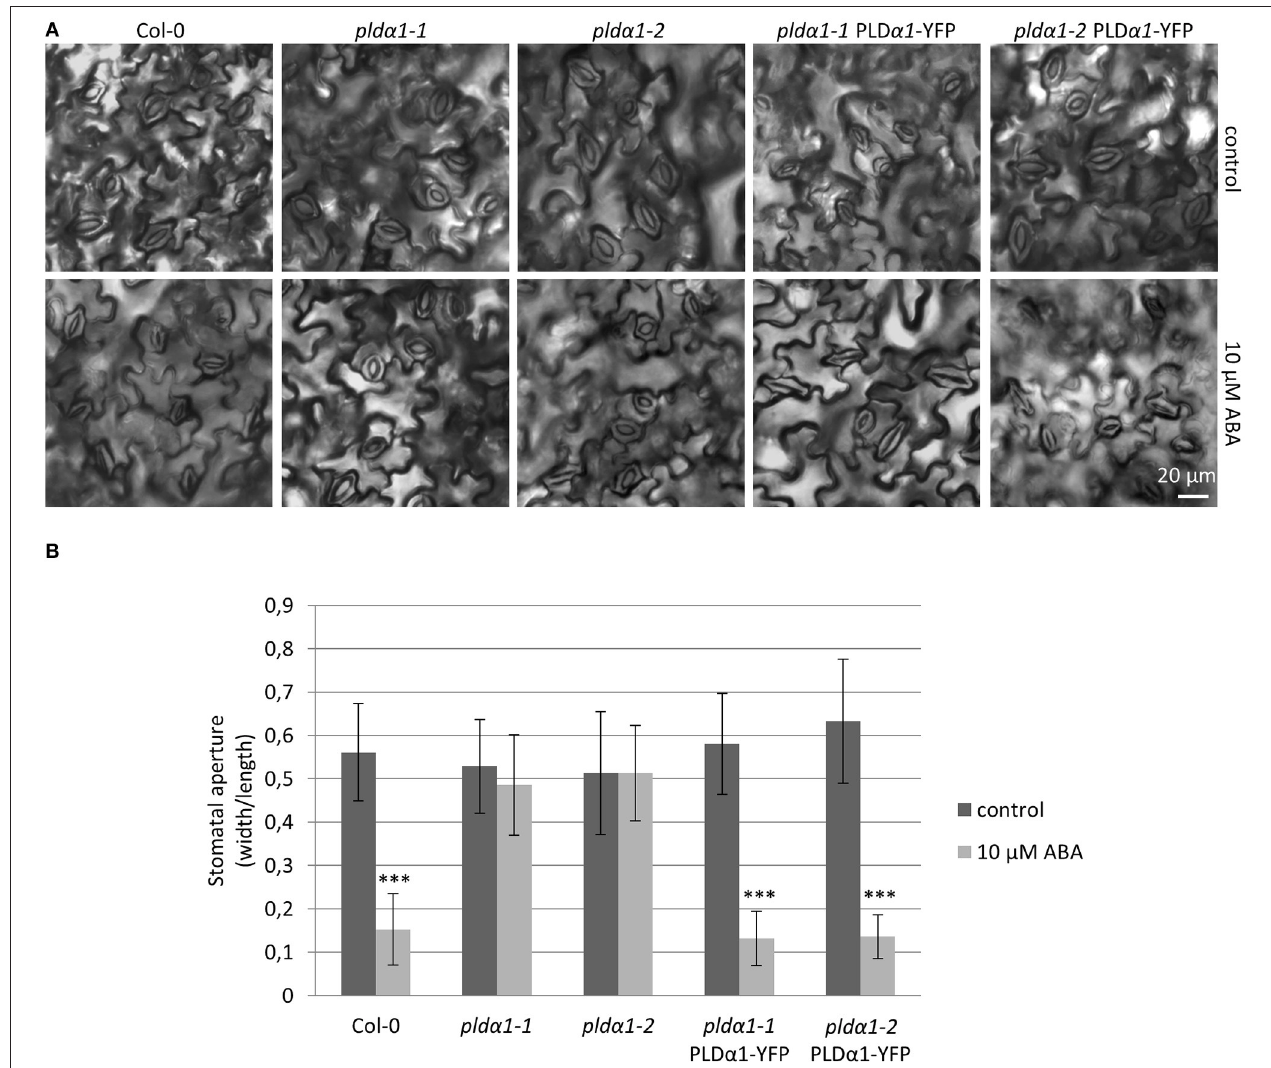
FIGURE 2 | ABA-induced stomatal closure in pld α 1 mutants and rescued plants. (A) Cotyledon epidermis of 7 days old Col-0, pld α 1-1, pld α 1-2, pld α 1-1 PLD α 1-YFP, and pld α 1-2 PLD α 1-YFP plants showing opening of stomata in control condition and after 2h treatment with 10 µ M ABA. (B) Aperture of cotyledon stomata guard cells of Col-0, pld α 1-1, pld α 1-2, pld α 1-1 PLD α 1-YFP, and pld α 1-2 PLD α 1-YFP (measured as a ratio of aperture width and length, which is reduced upon its closure) in control condition and after 2h treatment with 10 µ M ABA. Bar charts represent the mean ± SD for n = 40. Three asterisks indicate statistically significant differences (two-tailed paired t -test, P < 0.001) in stomatal